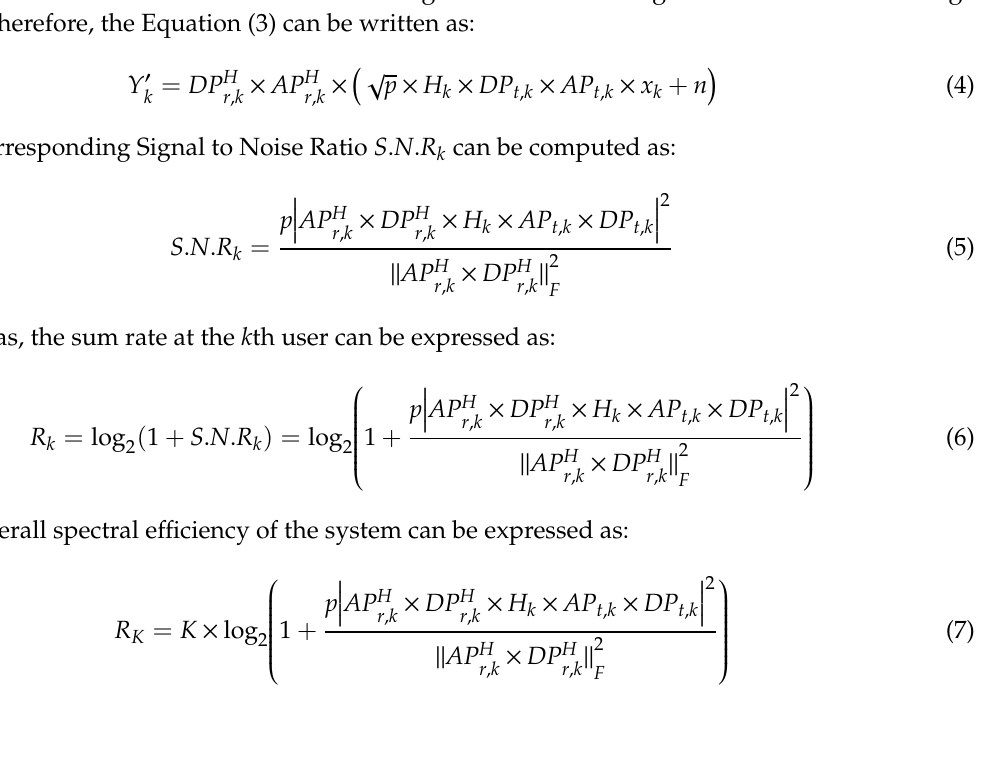
Figure 2. RF modified circuit configuration of mmWave Massive MIMO.